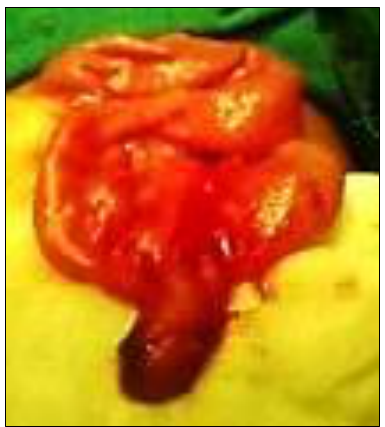
Figure 2: Meckel’s diverticulum delivered after reduction of